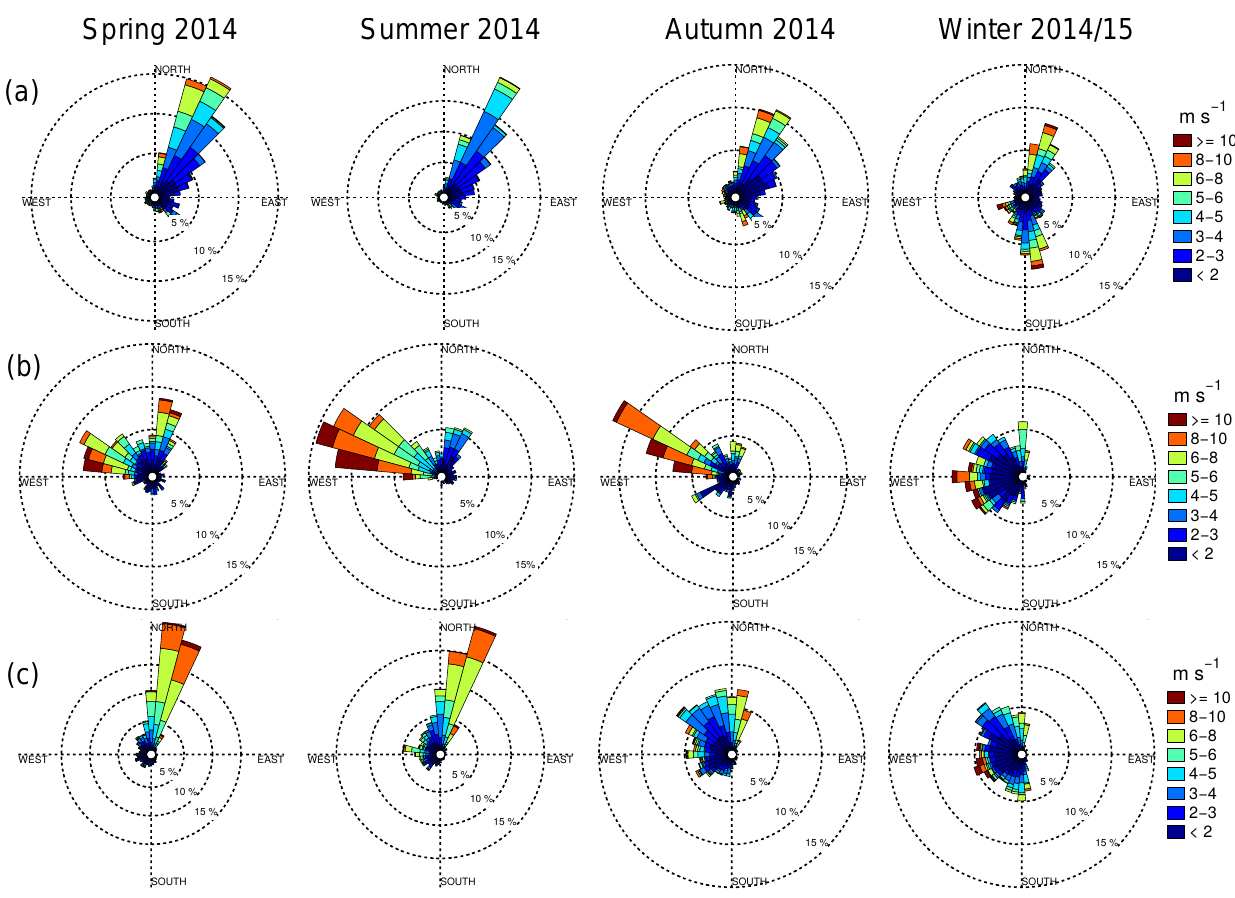
Figure 3. Wind conditions between (a) 06:30 and 17:30LT, (b) 17:30 and 20:30LT, and (c) 20:30 and 06:30LT. Data are shown for spring, summer, autumn, and winter